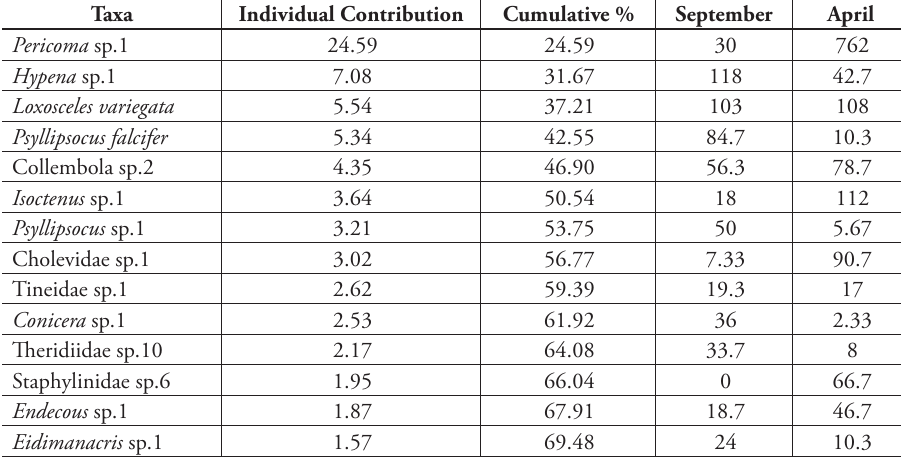
Table 3. SIMPER analysis. Species that mostly contributed to dissimilarity presented by entrance sectors in both sampling events. Taxa Individual Contribution Cumulative % Pericoma sp.1 Hypena sp.1